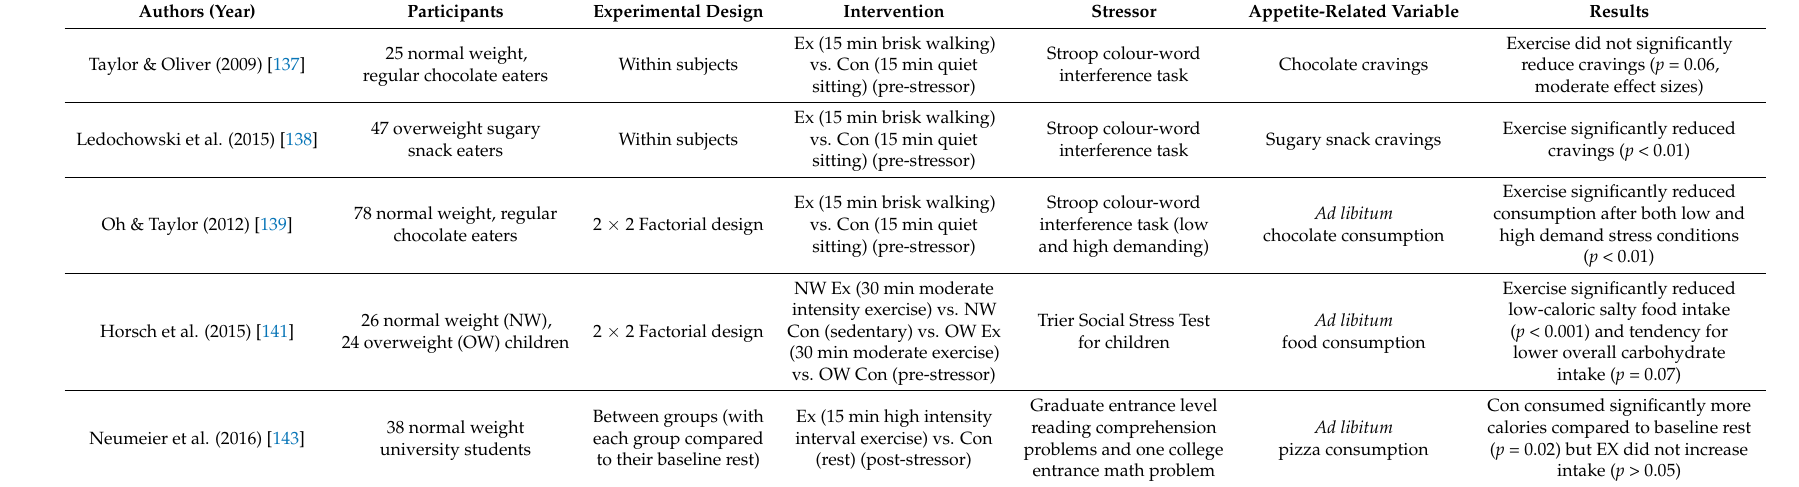
Table 1. Previous literature investigating the effects of physical exercise and stress on appetite-related